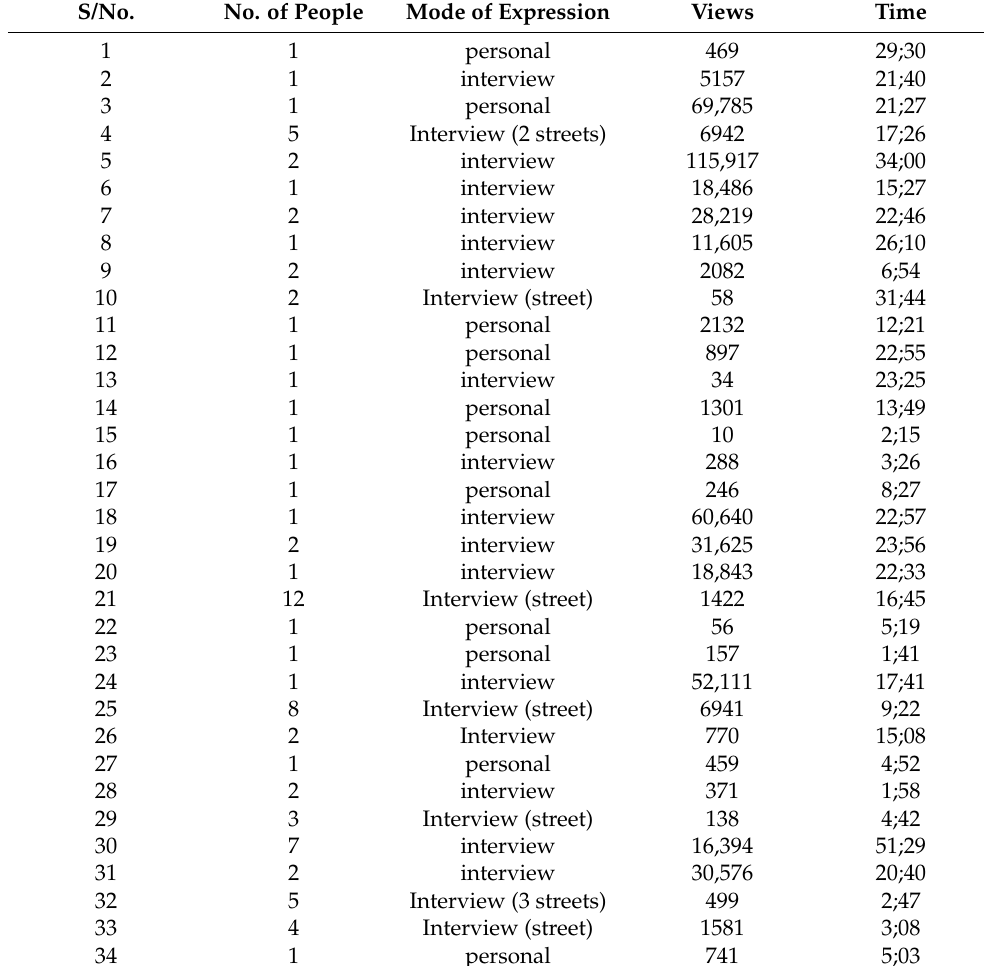
Table A1. Summary of the videos included for the